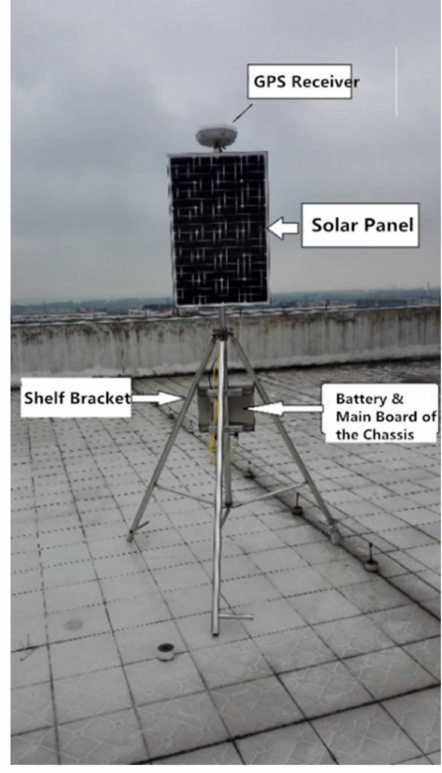
Figure 4. The test physical